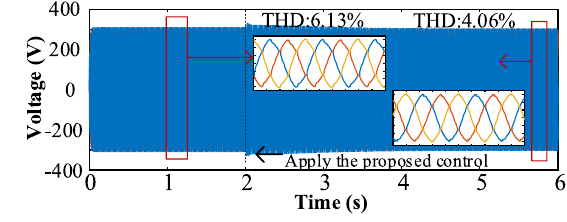
Fig. 19 Voltage waveform of bus 5